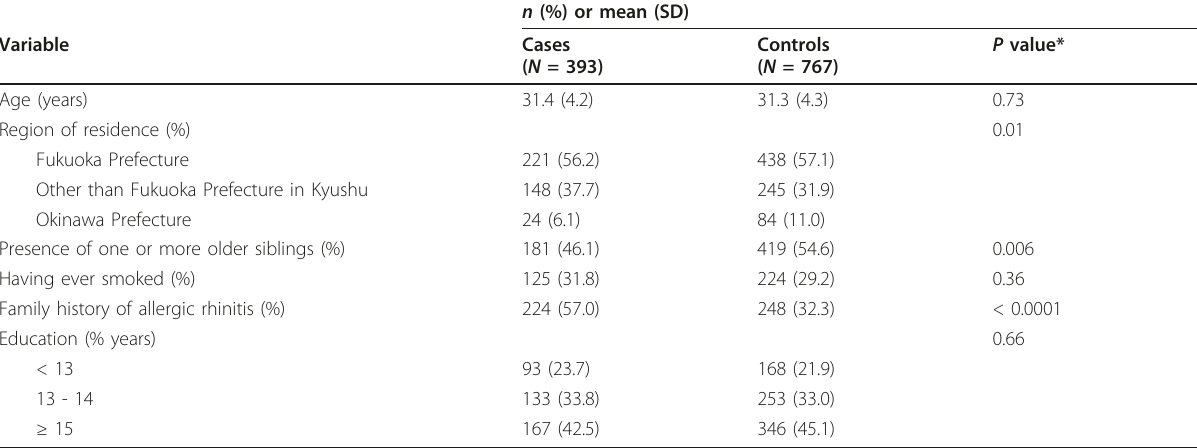
Table 1 Characteristics of the study population